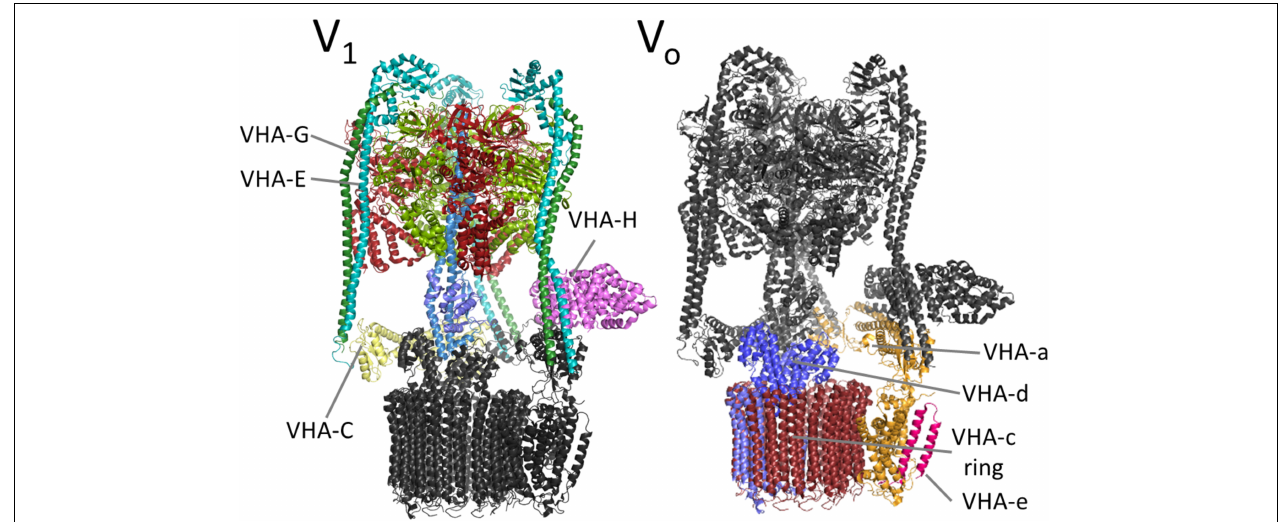
FIGURE 2 | V-ATPase complex. V-ATPase comprises of the membrane integral subsector V 0 and the membrane-associated subsector V 1 . V 0 is responsible for proton transport and dominated by a ring composed of ten molecules of proteolipid VHA-c. A single proteolipid is highlighted in blue (VHA-c”). ATP hydrolysis takes place in V 1 , in particular in VHA-A, and drives the rotation of the central stalk by VHA-D and VHA-F. The peripheral subunits serve as a scaffold and anchor the complex to the membrane via VHA-a. The structure is based on pdb7tmr (Vasanthakumar et al.,